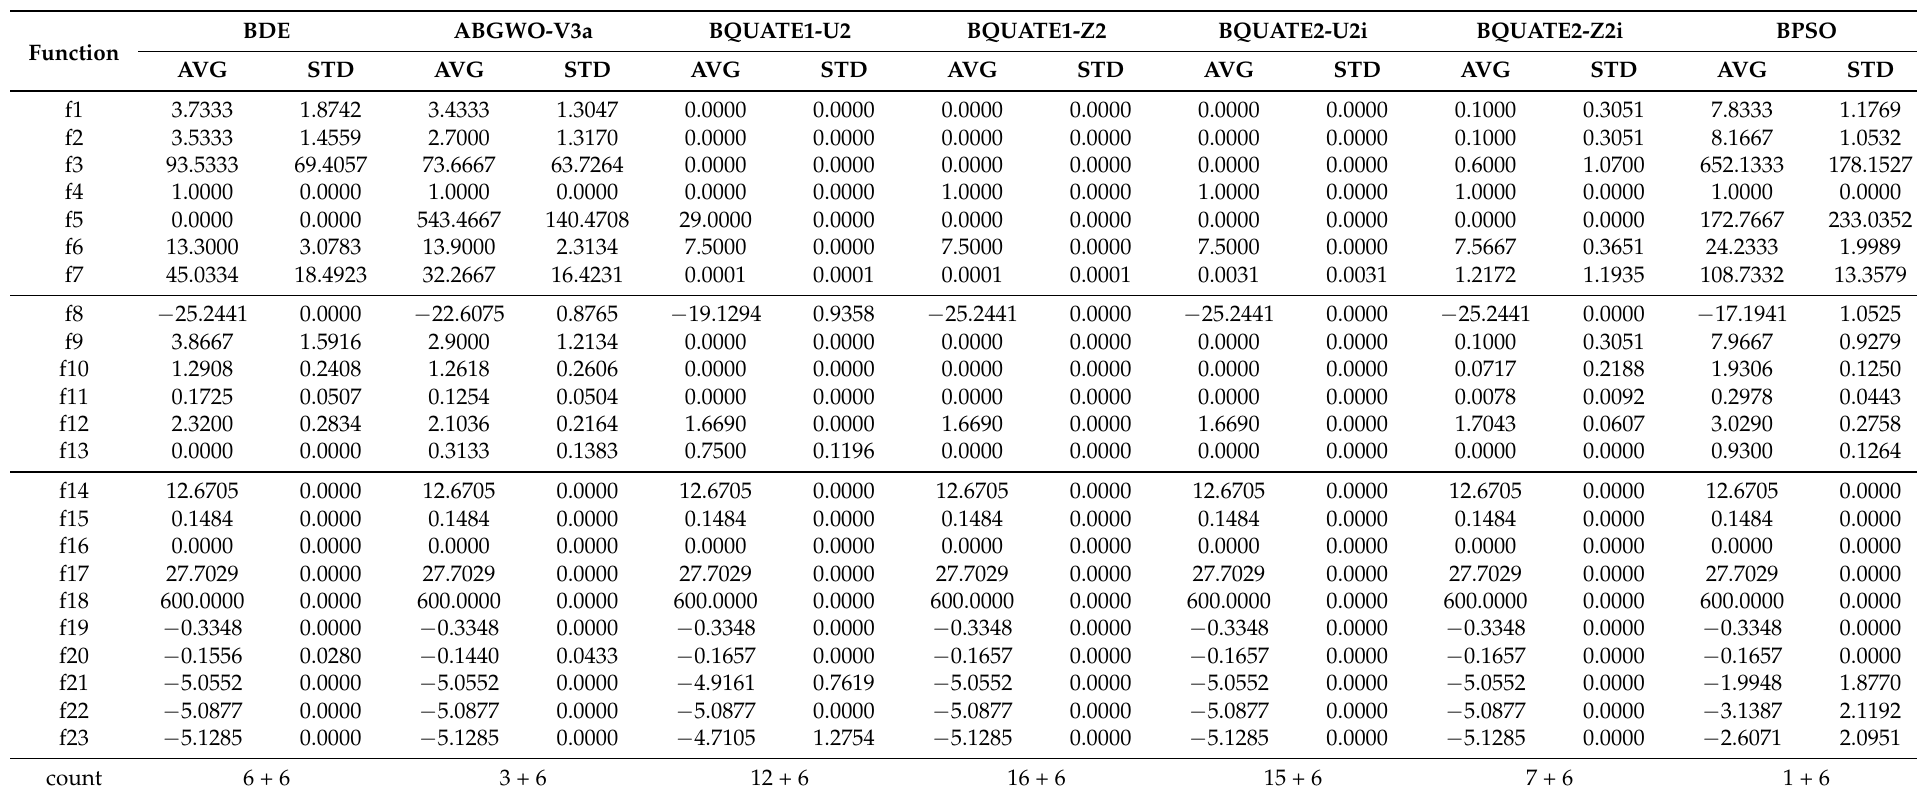
Table 14. The statistical results of BDE, ABGWO-V3a, BQUATE1-U2, BQUATE1-Z2, BQUATE2-U2i, BQUATE2-Z2i, and